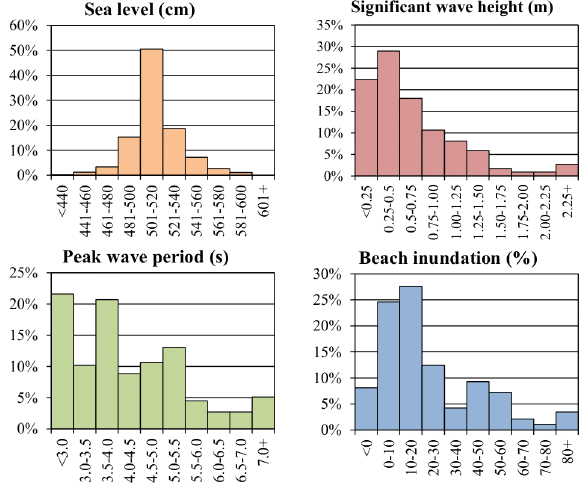
Figure 4. Histograms of parameters included in the study. Beach inundation pertains to actual (measured) wave run-up as % of the beaches’ baseline width.